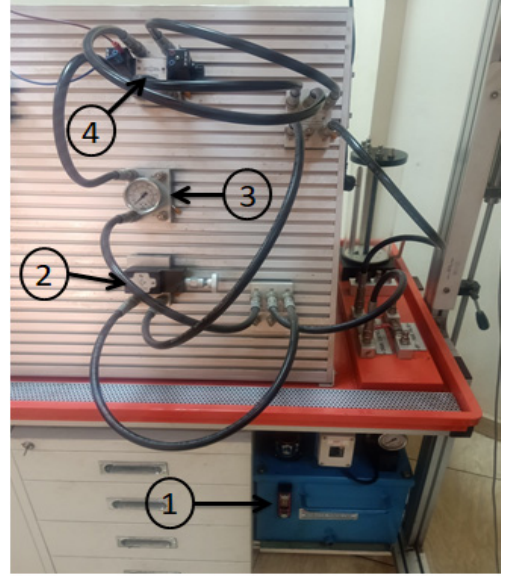
Figure 7 hydraulic circuit used to measure the effect of hydraulic force on solenoid valve spool dynamics. (1) hydraulic tank, (2) pressure relief valve, (3) pressure gauge, (4) solenoid